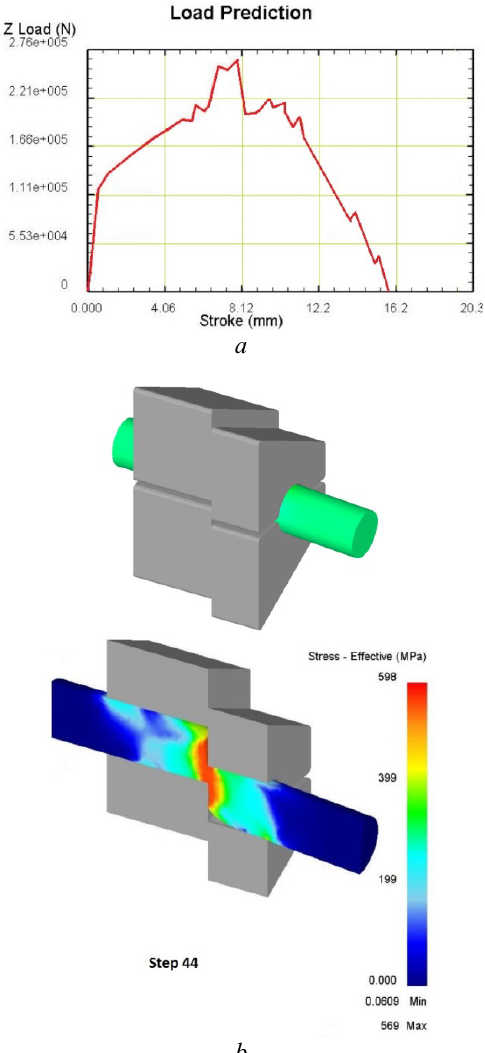
Figure 2. Cutting force vs. the stroke of the knife (a) and the distribution of stresses elongate the cross-section of rolled stock from steel 37Cr4